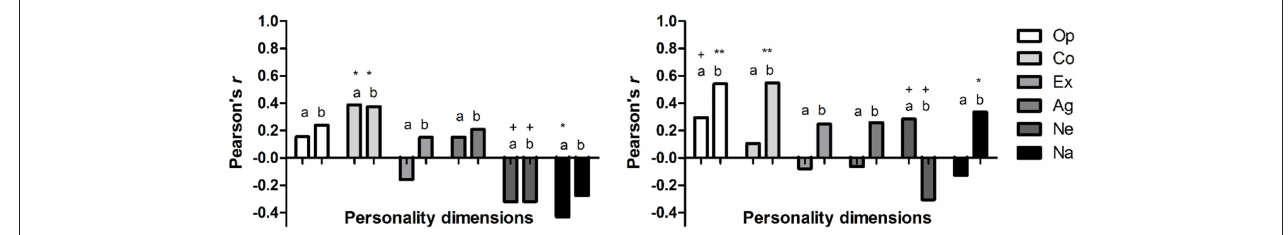
FIGURE 2 | Correlation coefficients of participants’ contact motivation with (a) nickname users’ self-reported personality dimensions and (b) participants’ personality judgments based on nicknames: intersexual (left: women rating men, right: men rating women). Op, Openness to experience; Co, Conscientiousness; Ex, Extraversion; Ag, Agreeableness; Ne, Neuroticism; Na, Narcissism. + p < 0.10, * p < 0.05, ** p <